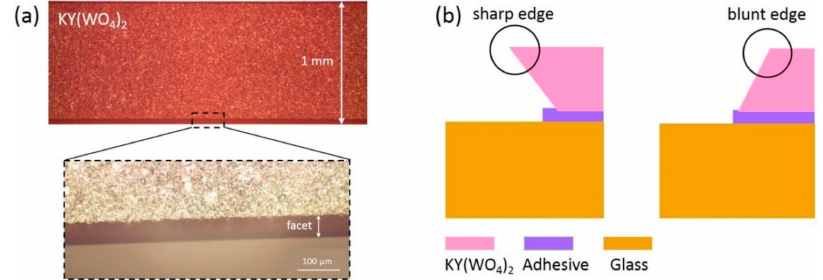
Figure 1. ( a ) Front view, microscope image of the edge of an as-delivered KY(WO 4 ) 2 sample from the manufacturer, showing the beveled facet and roughness. ( b ) Side-view illustration of a sharp and a blunt edge of a roughly 50 µ m thick KY(WO 4 ) 2 sample. The sharp edge is vulnerable to chipping, whereas the chance of chipping is limited for the blunt